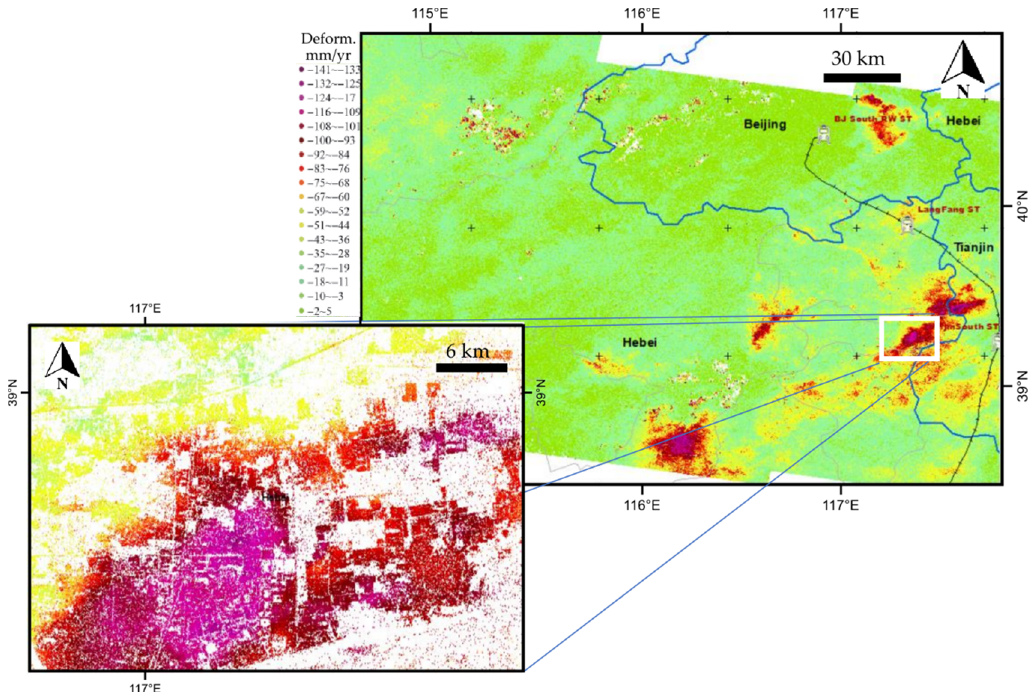
Figure 6. Sentinel 1 TOPS IW mod Small BAseline Sub-set (SBAS) subsidence map of Beijing South, with an enlarge subsidence map around Tianjin West.